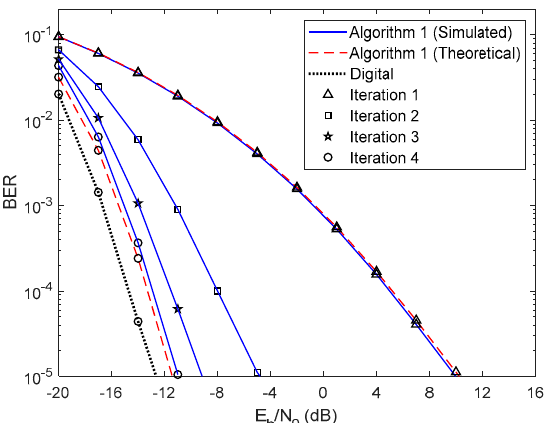
Figure 9. Performance of the proposed hybrid iterative multi-user equalizer (Algorithm 1) for the NCSI precoder with UPA configuration and QPSK modulation.